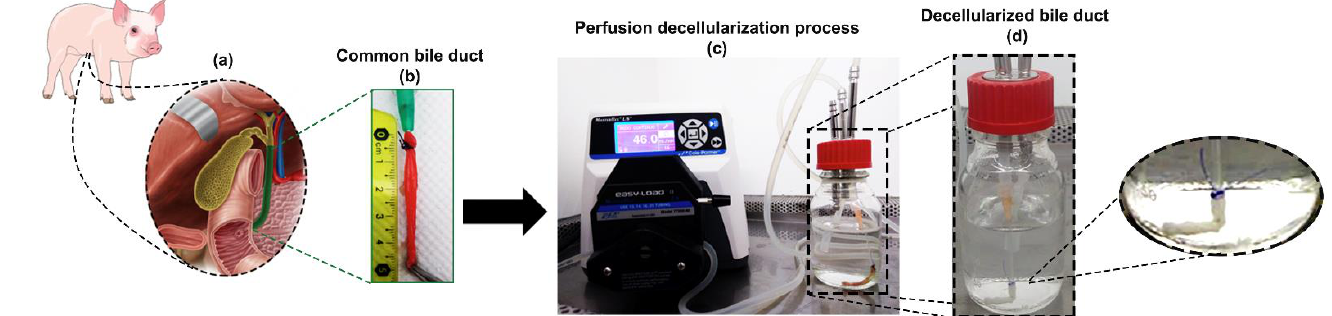
Figure 1. Surgical process and decellularization process. Traction of the fundus of the gallbladder and a reference of the porcine biliary tract was conducted with the previous enterotomy of the second portion of the duodenum and the splinting of the Vater's ampulla. ( a ). Extrahepatic native biliary tract ( b ). Perfusion of the bile duct in a closed circuit by a peristaltic pump ( c ). Images depict change from native ( c ), resulting decellularized bile duct appeared white ( d ).